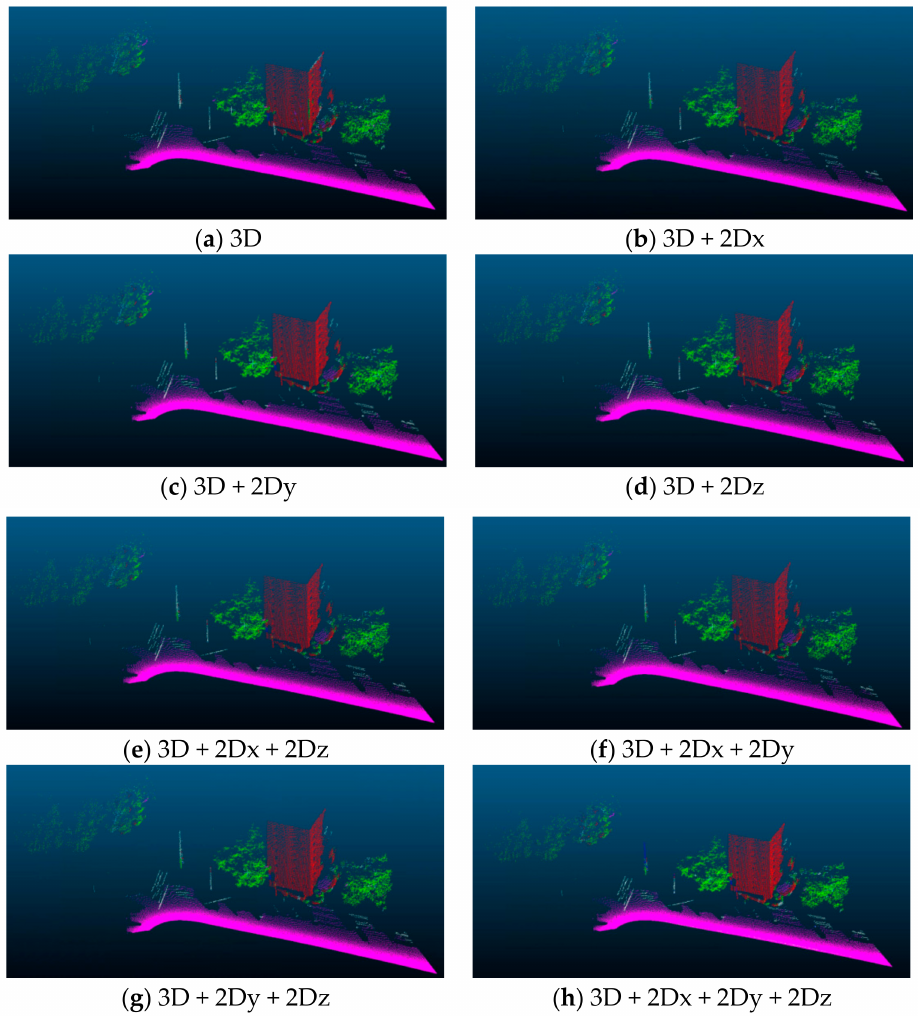
Figure 9. Visualization result of the comparison